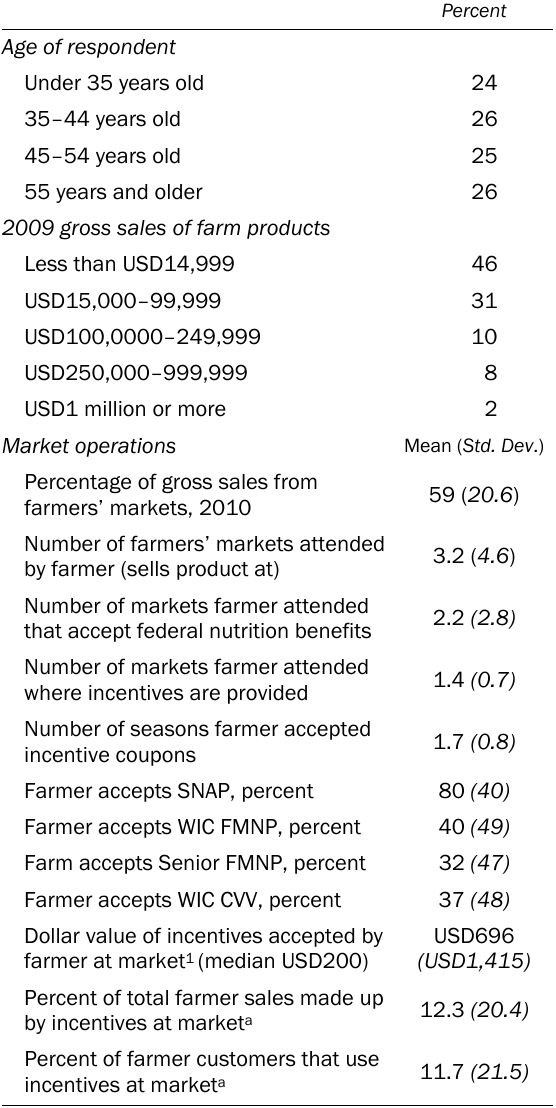
Table 3. Demographic Characteristics of Respondents and Farm Operations